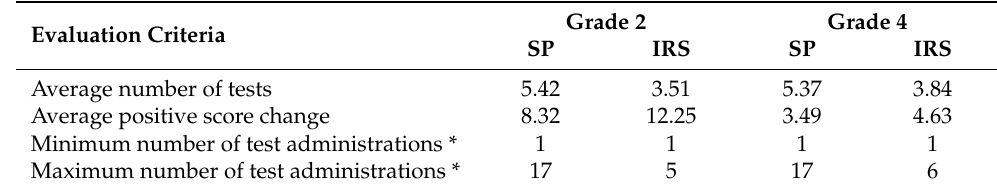
Table 2. Results of the intelligent recommender system (IRS) compared to standard practice